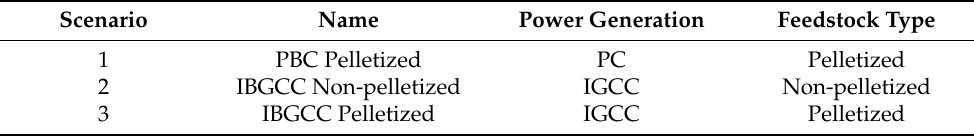
Table 1. Three scenarios used to evaluate the cost of BECCS in the U.S. in 2040.